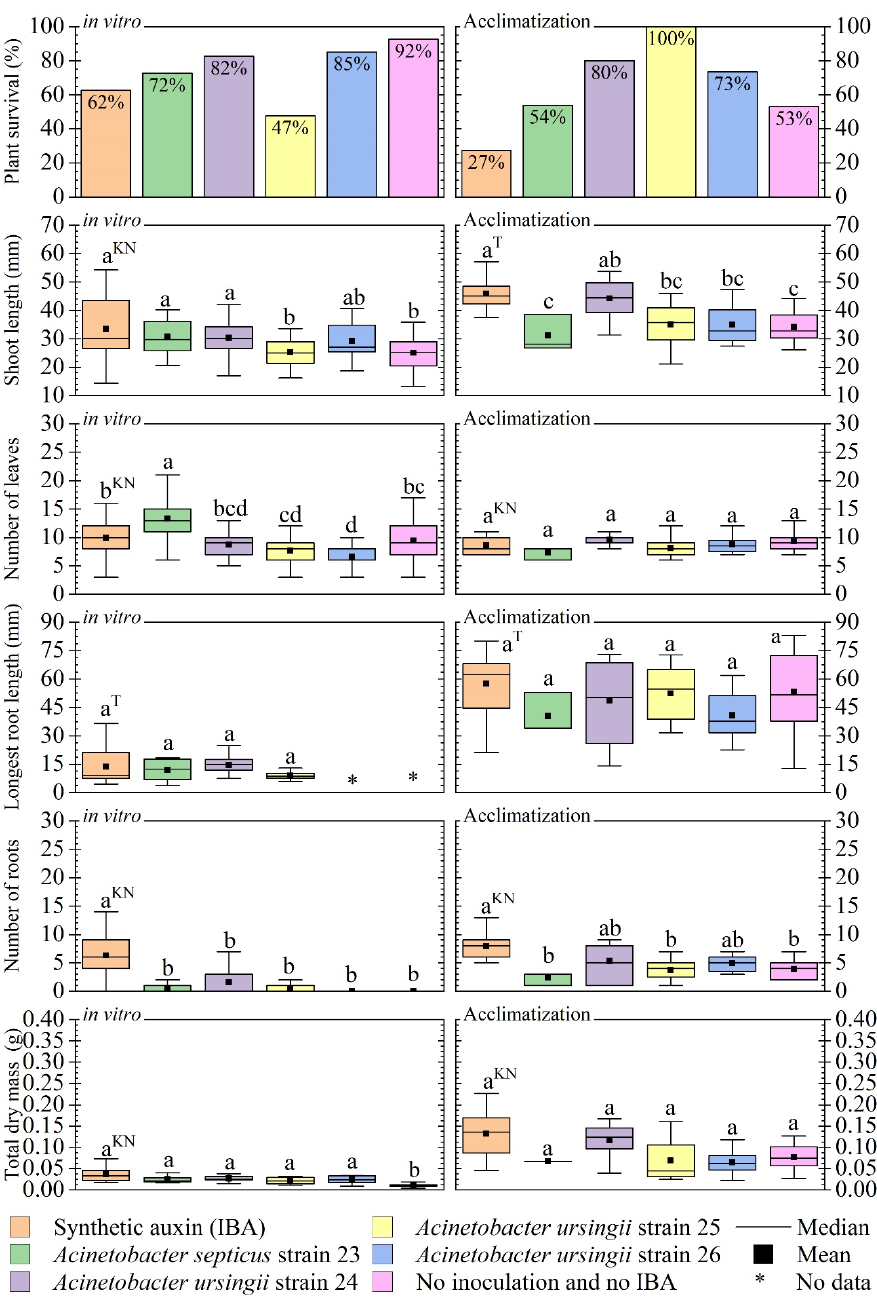
Figure 5. Boxplot and statistical tests for in vitro inoculation and acclimatization of ‘PDW’ rootstock. Legend: Statistics: T—means followed by the same letter do not differ by the Tukey test at the 5% confidence level; KN—means followed by the same letter do not differ by the Kruskal-Wallis-Nemenyi test at the 5% confidence level. Lowercase letters indicate significant